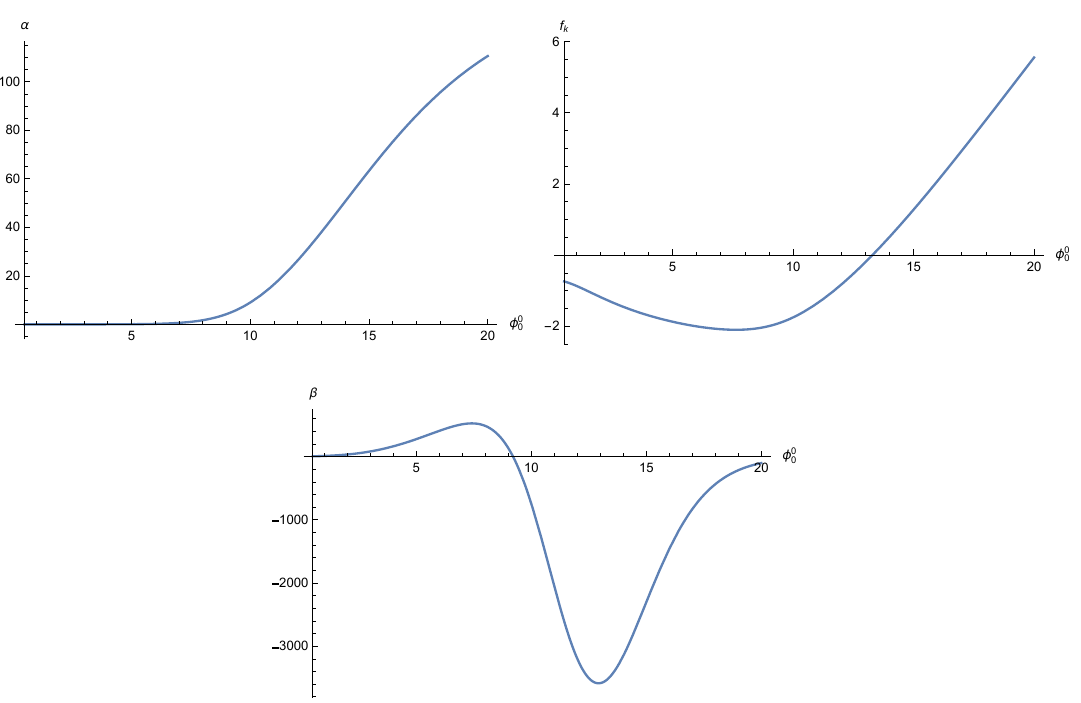
Figure 2 . Dependences of the UV expansion parameters f k , (cid:11) , and (cid:12) on the IR expansion param- eter (cid:30) 0 . 0